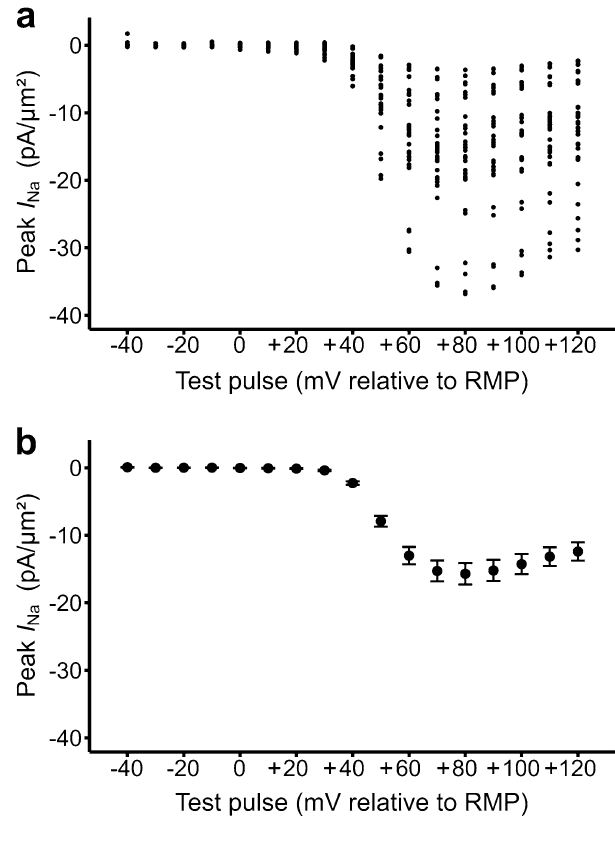
Figure 1. Current–voltage ( I–V ) relationships between patches. Data from ( a ) individual patches showing between-patch, normally distributed (n = 17; Shapiro–Wilkes test, P = 0.13), variations in peak currents obtained through the explored range of applied voltage steps, with ( b ) their means and standard